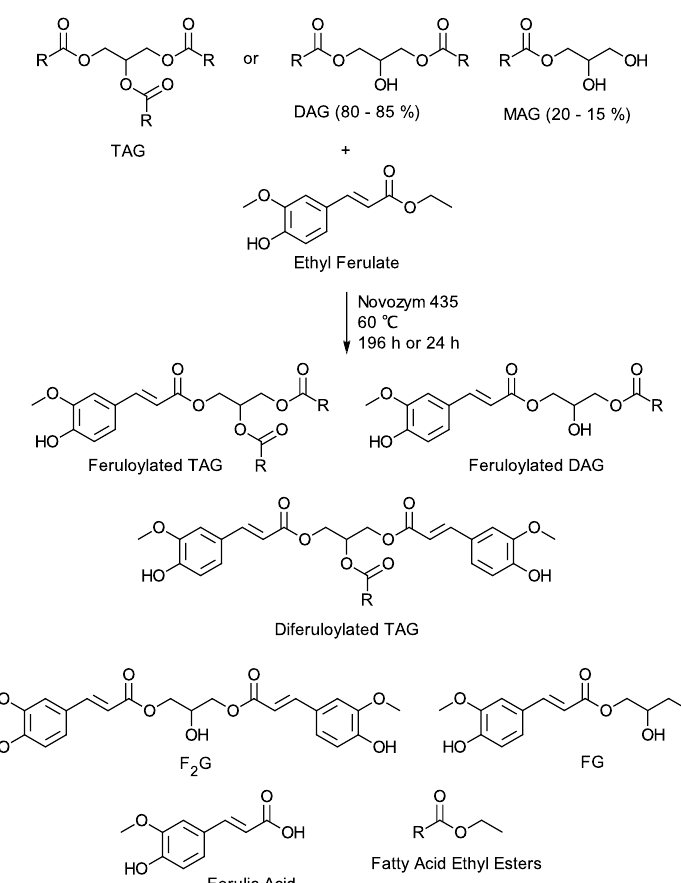
Figure 1. Schematic of the transesterification of vegetable oil TAG or vegetable oil mixture of DAG and MAG with ethyl ferulate, R = vegetable oil fatty acid (e.g., 18:0, 18:1, 18:2, 16:0). Major products: feruloylated triacylglycerol (TAG), feruloylated diacylglycerol (DAG), and diferuloylated TAG. Minor products: feruloylated glycerol (FG), diferuloylated glycerol (F 2 G), and ferulic acid. The product mixture also contains unreacted ethyl ferulate, unreacted vegetable oil, and vegetable oil fatty acid ethyl esters.